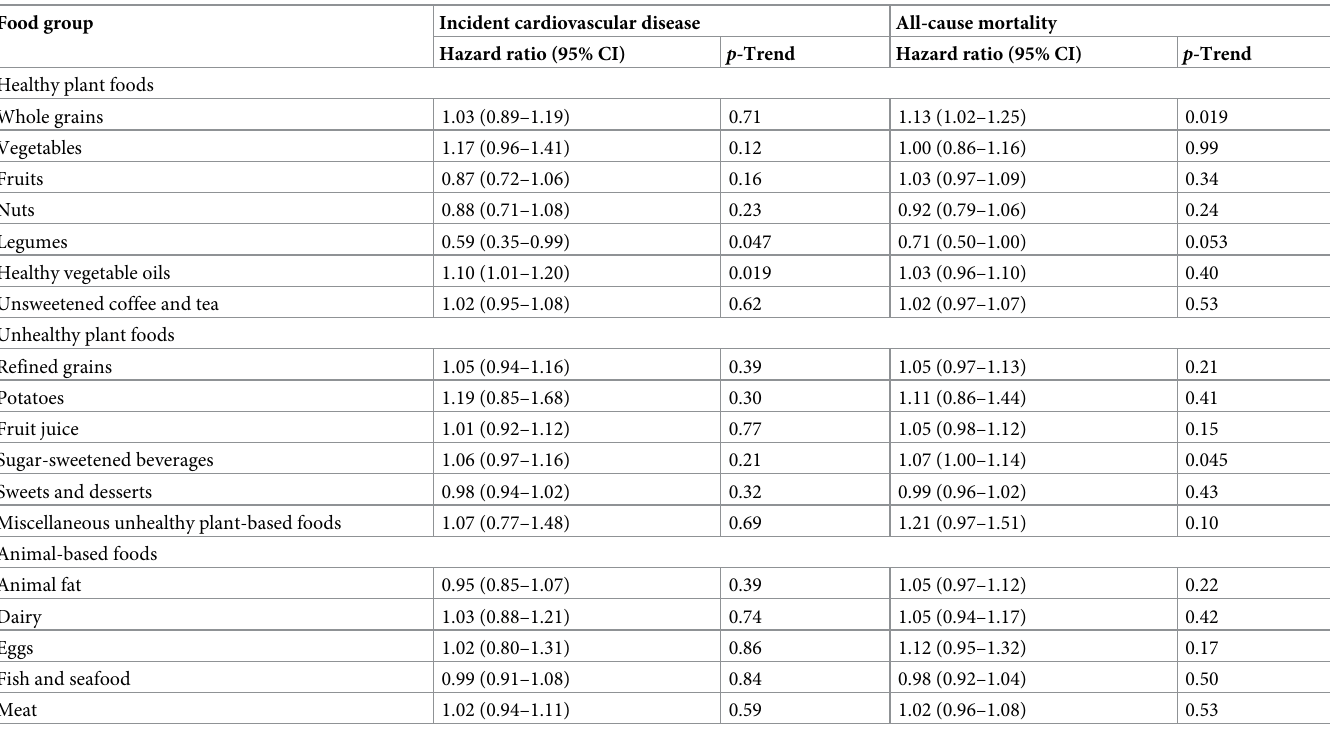
Table 5. Adjusted hazard ratios (95% CIs) for incident cardiovascular disease and all-cause mortality per 1-serving increase in individual food groups.